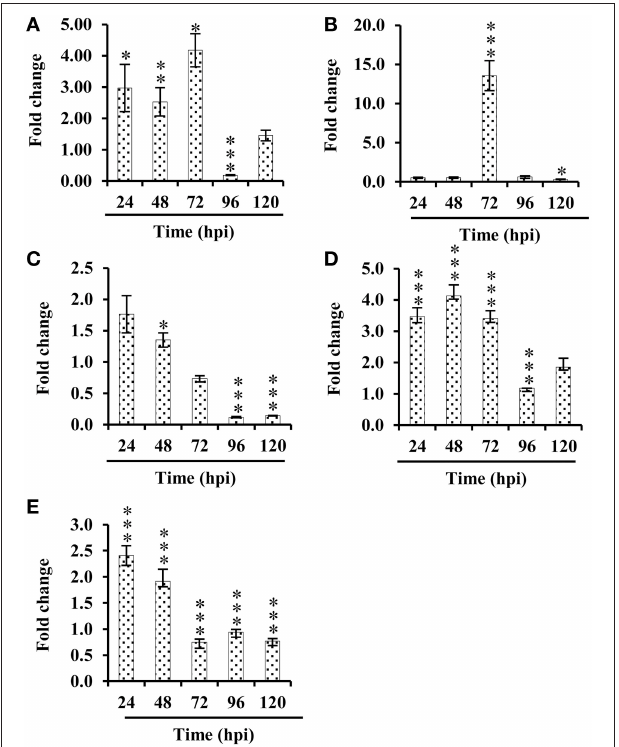
FIGURE 5 | Relative quantification (RQ) of mRNA levels. Five candidate genes differentially expressed in tomato fruits challenged with S. rolfsii at 24, 48, 72, 96, 120 hpi. Expression changes were analyzed by ANOVA and vertical bars indicates SE. Significantly up- or down-regulated genes are indicated by * p < 0.05 (Tukey post-hoc test). (A) 1-aminocyclopropane-1-carboxylate oxidase, (B) Stress induced protein sti1-like protein, (C) Actin depolymerizing factor, (D) Inositol monophosphatase 3, (E) late embryogenesis abundant protein.